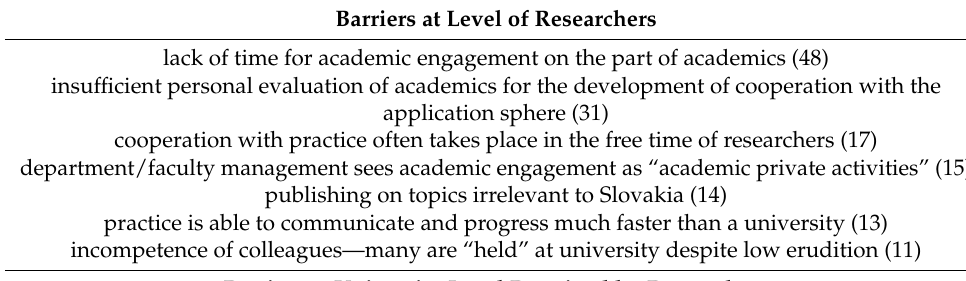
Table 2. Vertical hierarchy of academics’ attitudes towards barriers of academic